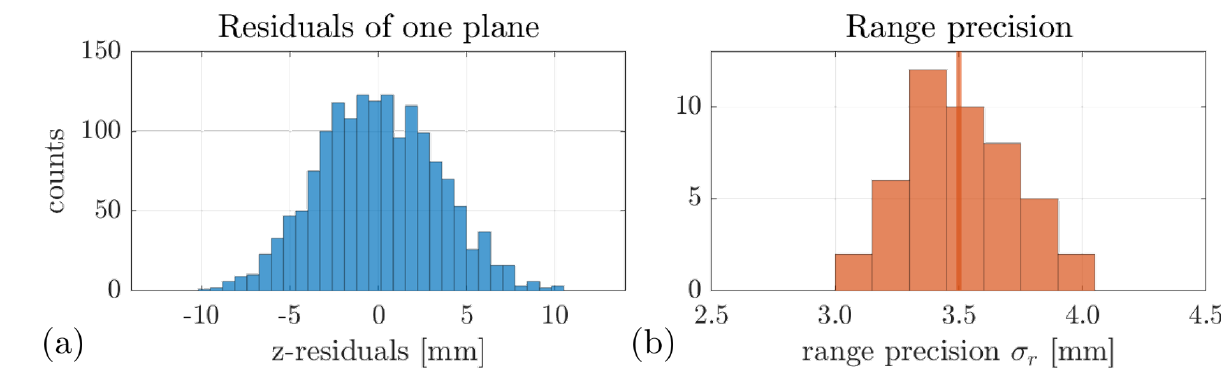
Figure 6. Evaluation of point cloud noise with residuals regarding plane estimation for an example plane ( a ) and the histogram of all range precision estimated based on four data sets ( b